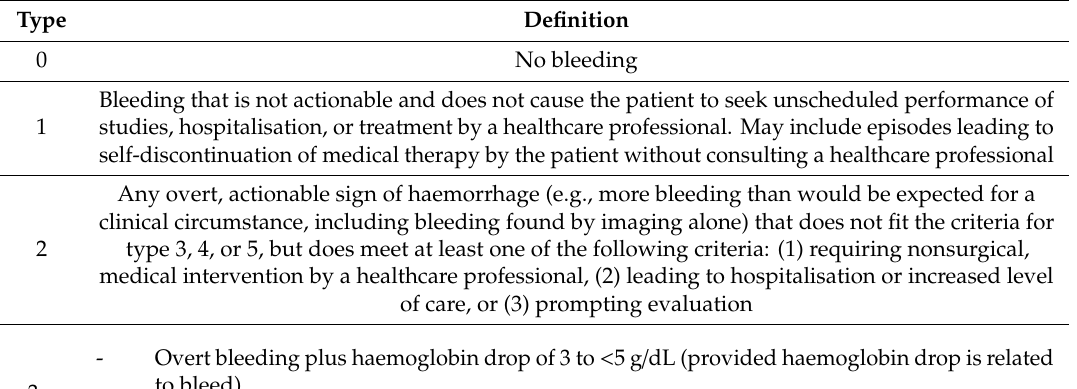
Table A1. Bleeding Academic Research Consortium (BARC) definition of PCI-related bleeding